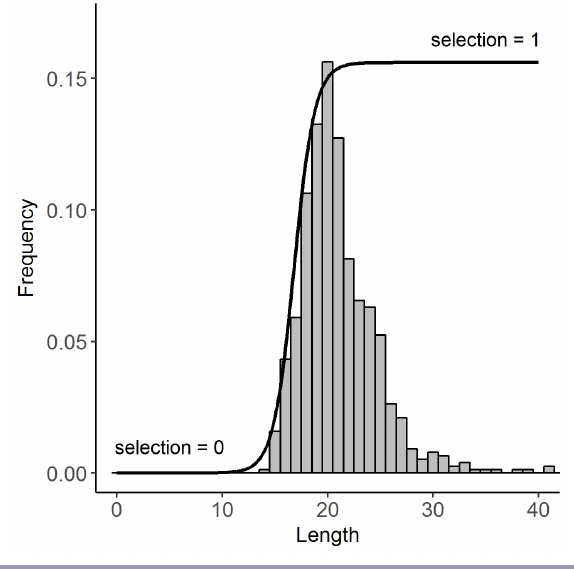
Fig. 2 . Size distribution of free divers’ catch in 2014 (gray histogram) and the size selection (black curve) fitted to those data. Selection = 1/(6.41 × (1 + exp(−1.02(length −